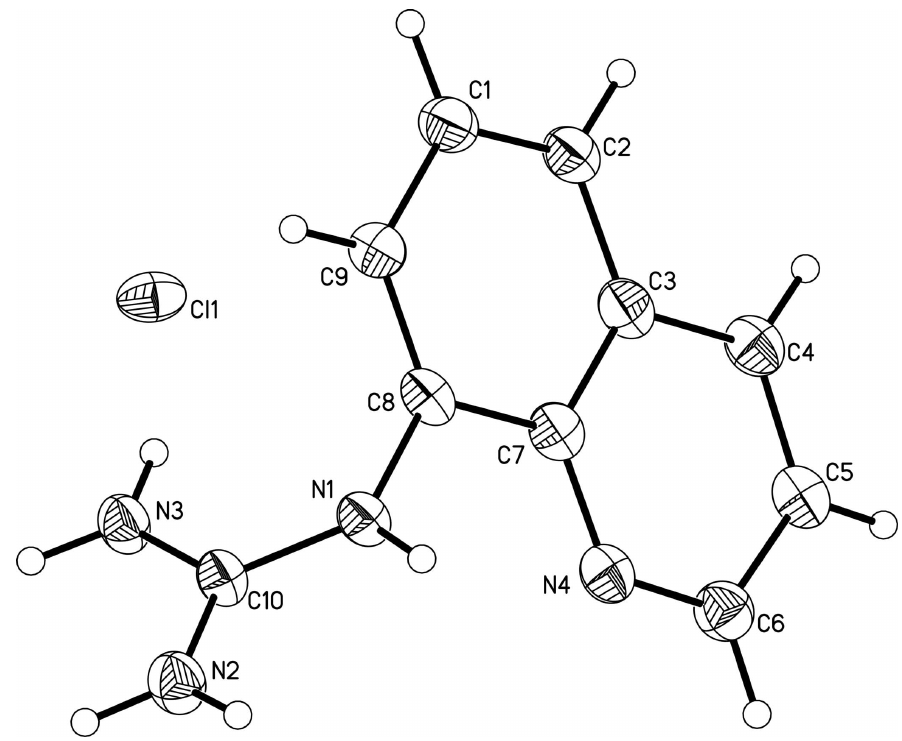
Figure 1 The molecular structure drawing for (I) showing 50% probability of displacement ellipsoids and the atom-numbering